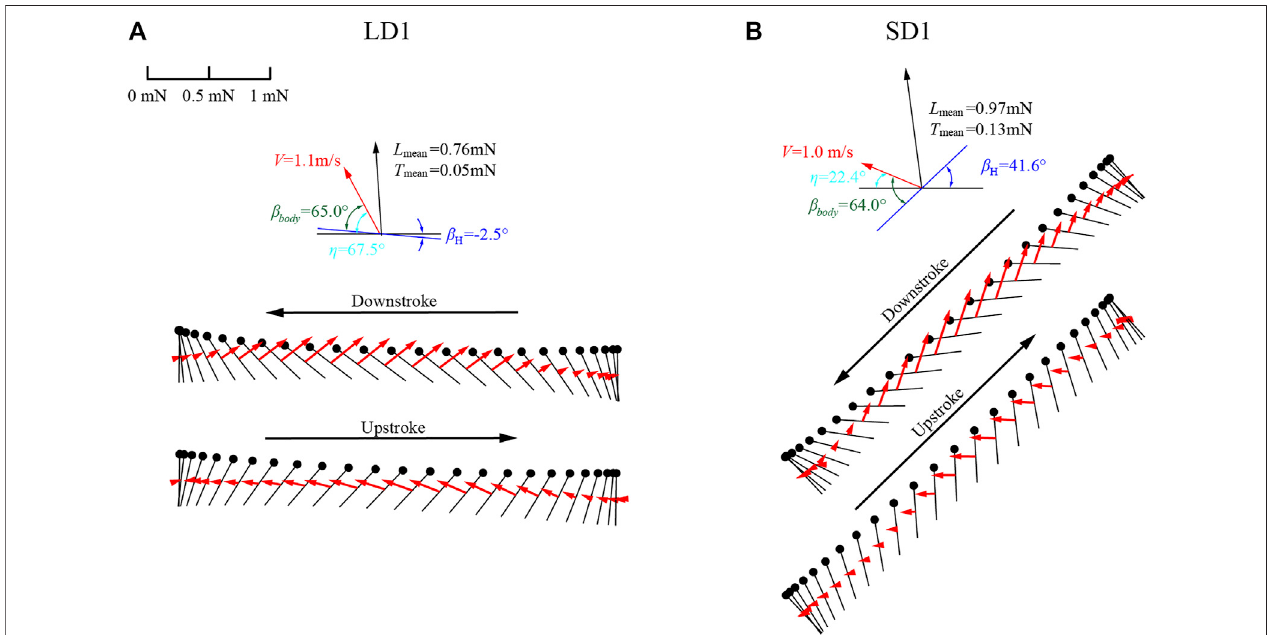
FIGURE 8 | Diagram of wing motion and aerodynamic force vectors during (A) LAC and (B)